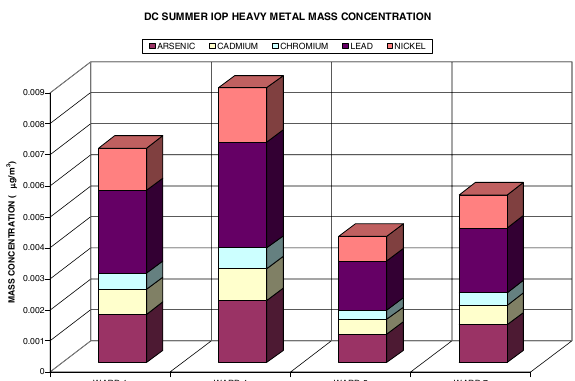
Figure 5: Heavy Metal Content of Fine PM for Summer IOP